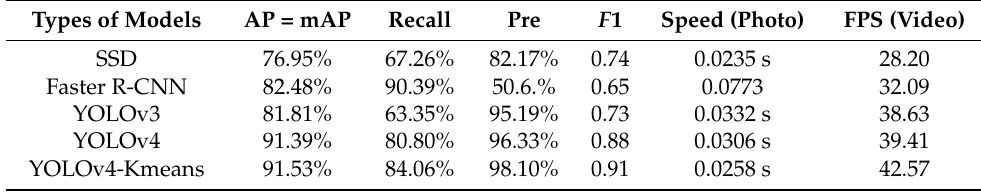
Table 6. Comparison of different model evaluation index parameters. Types of